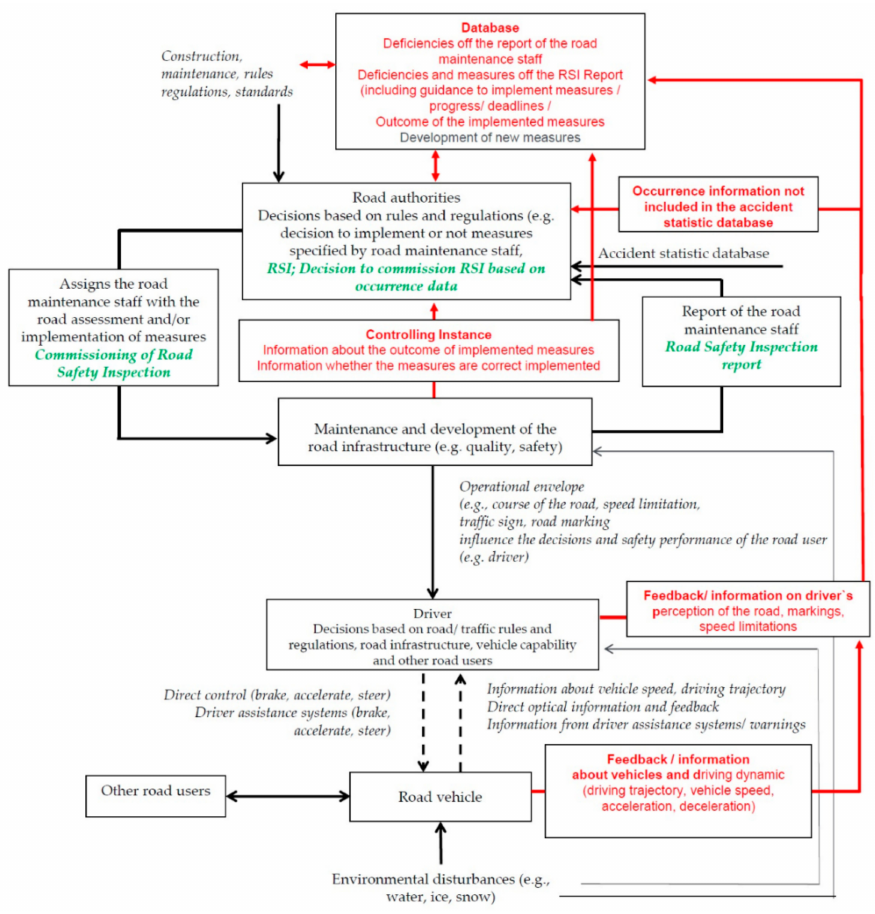
Figure 2. Proposed improvement of the control structure. New elements generated by the STPA analysis are colored in red. STPA Step